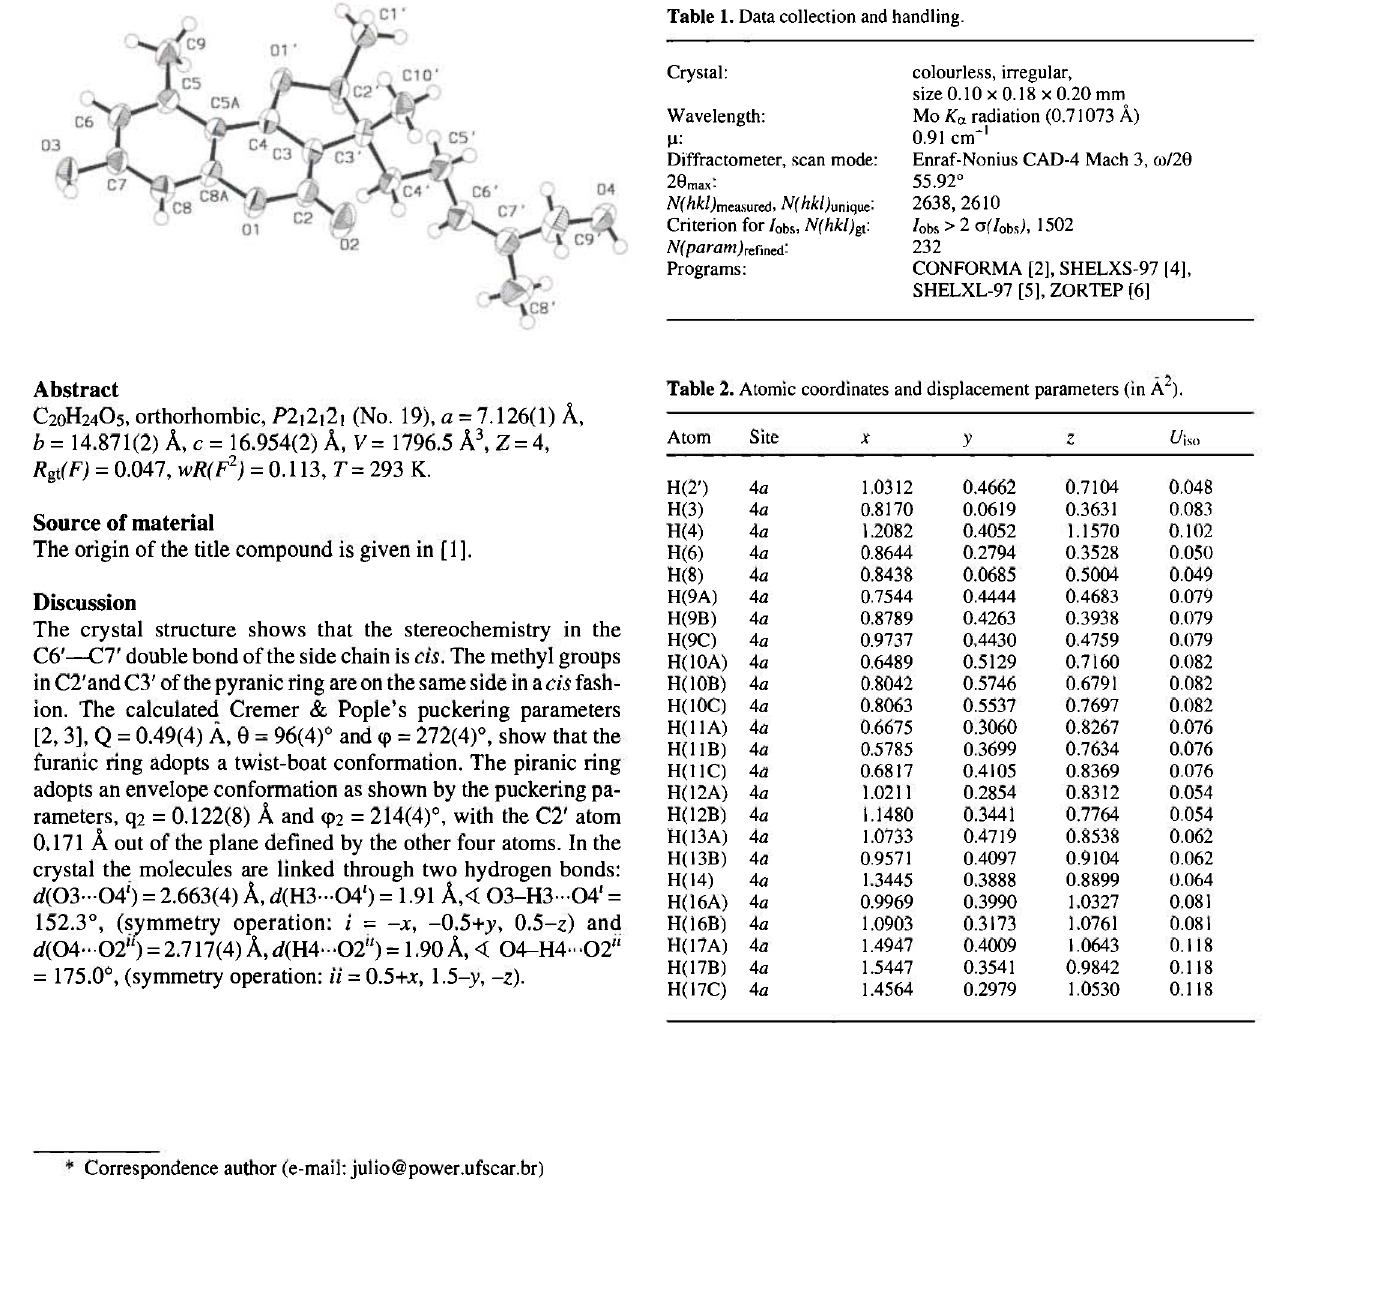
Table 1. Data collection and handling.